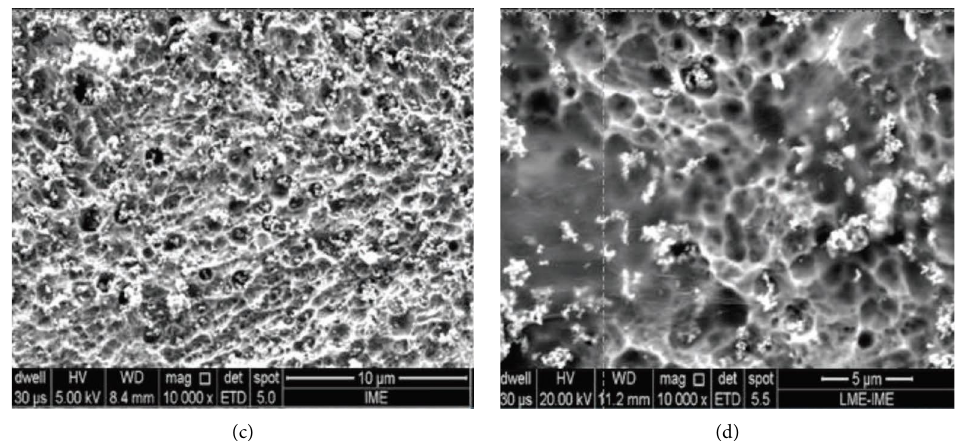
Figure 4: Ti surface morphology before and after graphene coating. (a) cp Ti before coating. (b) cp Ti-GO. (c) cp Ti-NB. (d) cp Ti-NBGO.